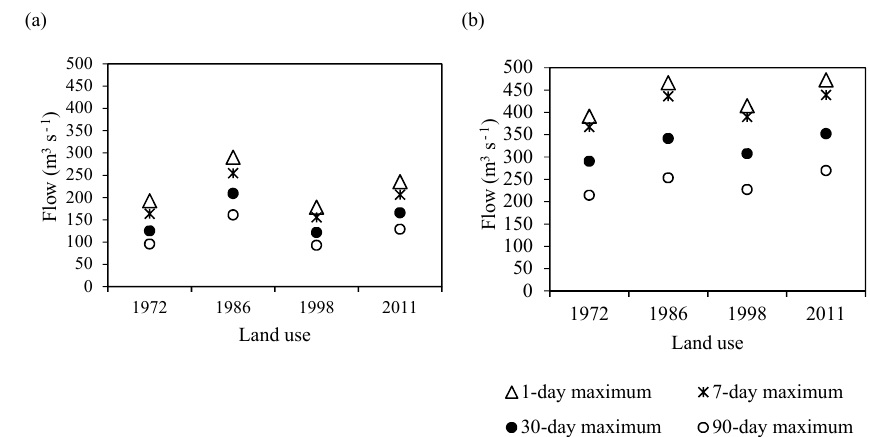
Figure 12. Median flow maxima for 1, 7, 30 and 90 day intervals from the land use data from 1972, 1986, 1998 and 2011 for (a) Rahad River and (b) Dinder River.